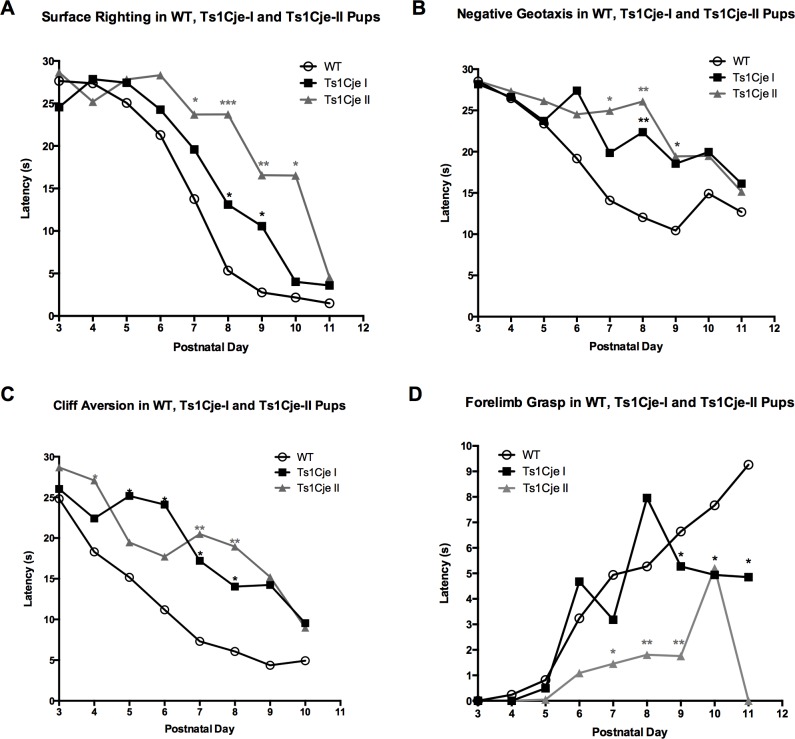
Developmental Milestones in the Ts1Cje-I (post-weaning survivors) and Ts1Cje-II (pre-weaning deceased) neonates versus WT littermates.Ts1Cje-II (pre-weaning deceased) growth restricted pups (n = 16) showed significant deficits in the surface righting (A), negative geotaxis (B), forelimb grasp (D) and, to a lesser extent, in the cliff aversion test (C) compared to the Ts1Cje-I (post-weaning survivors) (n = 16) and WT (n = 64) littermates. Data are represented as mean ± SEM. * (p<0.05), ** (p<0.01) and *** (p<0.001). Significance values presented in the figure represent comparisons to WT pups.